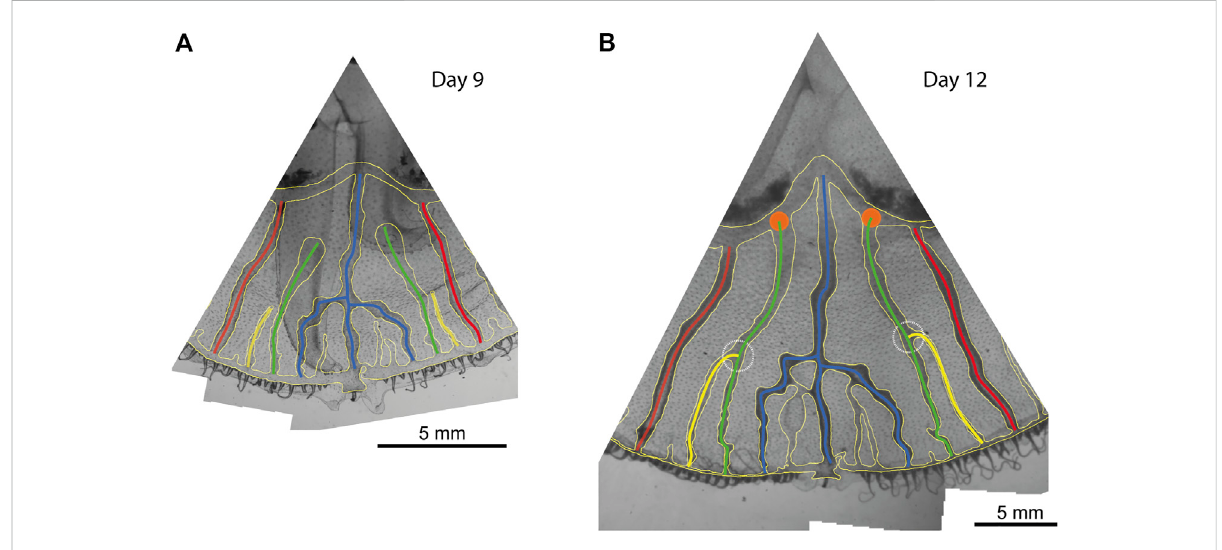
FIGURE 7 Twosuccessiveimagesofajelly fi shoctant. (A) Atday9ofobservation,secondary(green)sidecanalsdidnotconnecttothecentralonesandare reaching toward the stomach pouches. Similarly, there are two younger (yellow) canals growing aside of them without connecting either. (B) 3 days after, the side canals have reached the stomach pouch and connected (orange disks), and in the same period, the younger canals have also connected to these side canals (dashed white